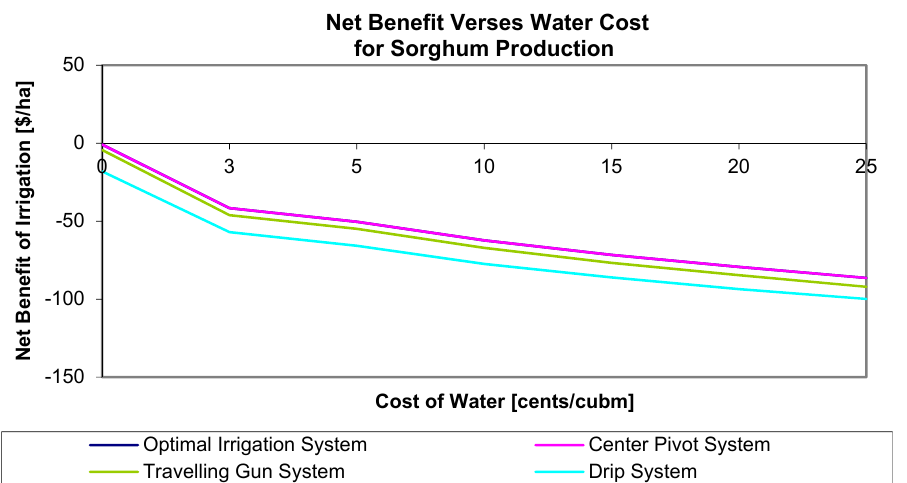
Figure 5. Irrigation system comparison of net benefit versus water cost associated with wheat production.